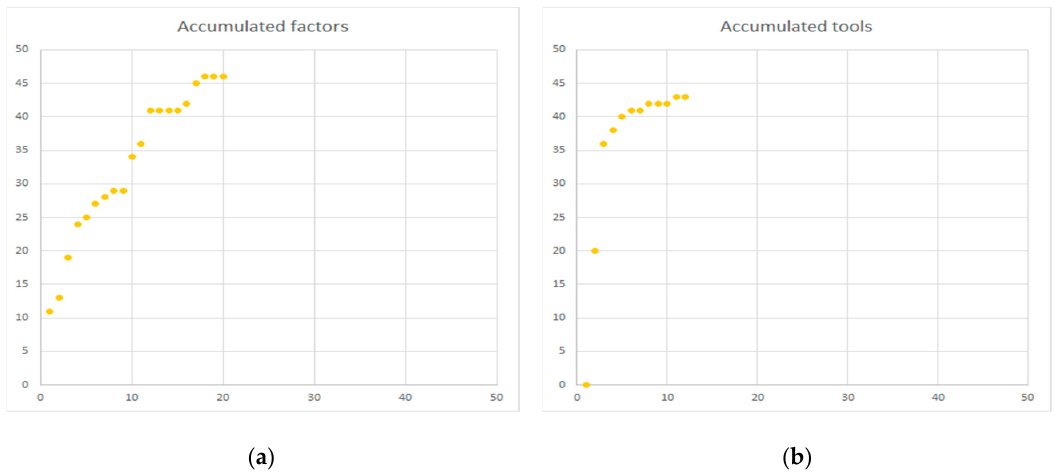
11 of 48 Figure 5. Selection process of references disaggregated to data sources. The final articles, after confirmation in the text, that they contribute to study results, were selected in a bottom-up manner, by defining a threshold for data saturation. The data saturation threshold is a way of determining after how much articles does the research become redundant [86]. In studies, where the task of the observations is to provide new labels or classes, there is a